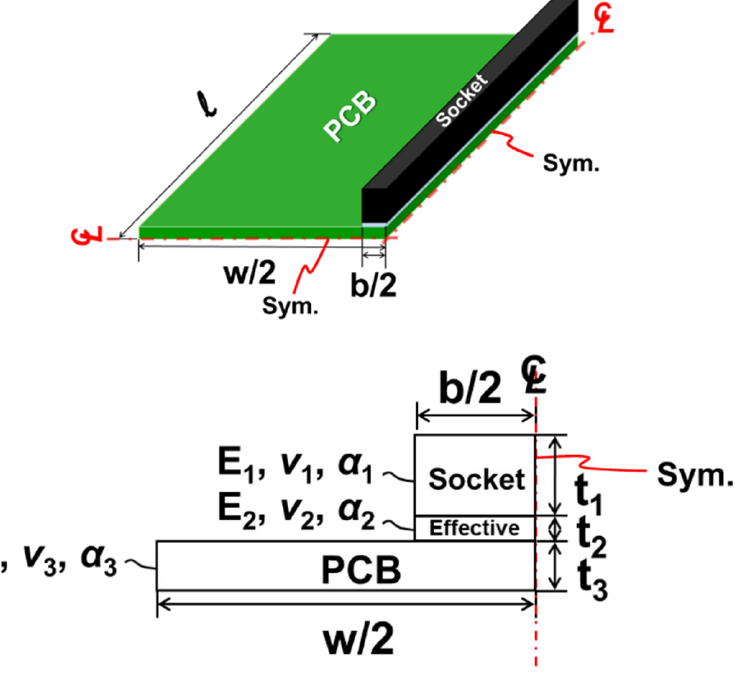
Figure 6. Quarter model of a socket-PCB assembly with one socket and its related geometric and material parameters in the theoretical formulation.